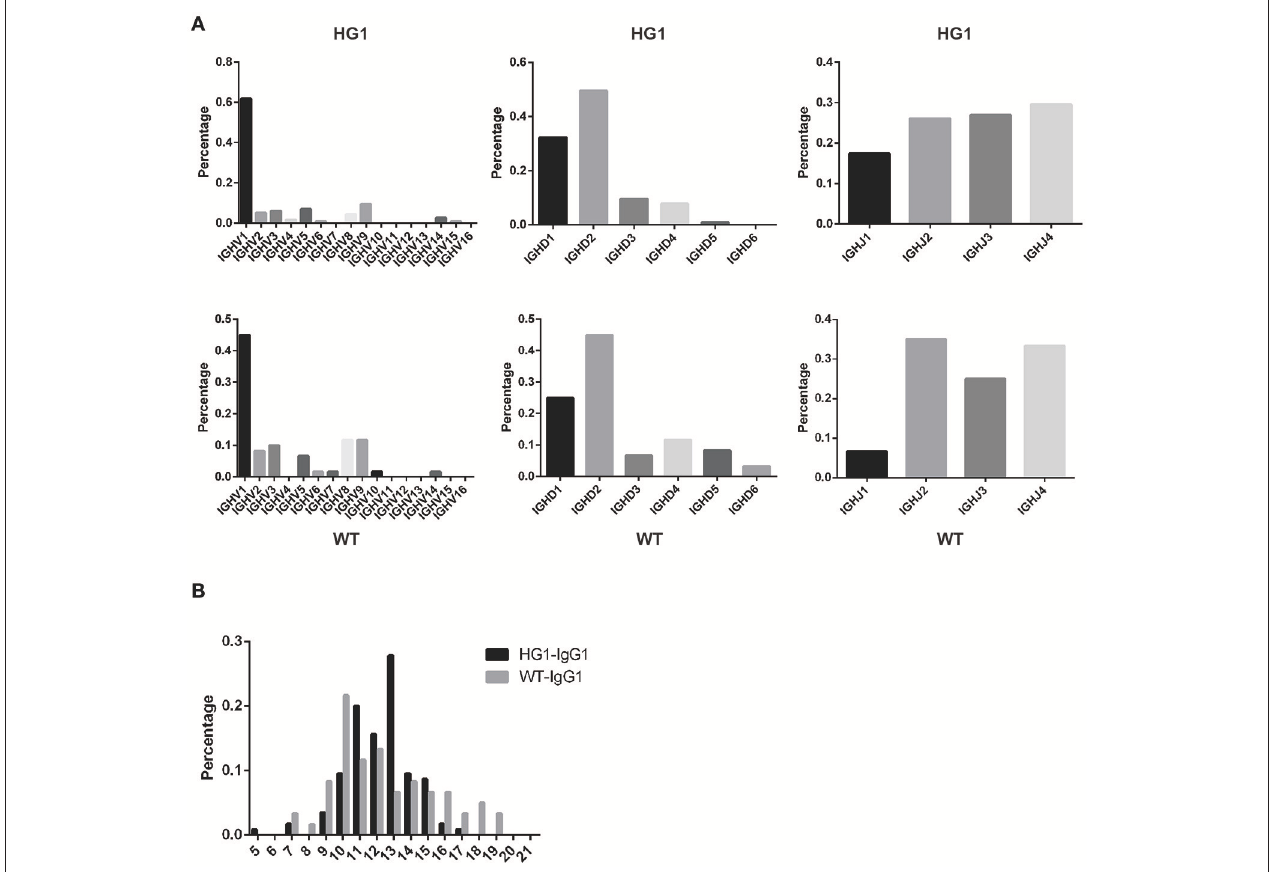
FIGURE 4 | VH gene usage and CDR3 length analyses. (A) The usage of the V, D, and J genes of the γ 1 transcripts in HG1 (upper panel) and WT (lower panel) mice. (B) Analysis of the length of CDR3 in the IgG1 heavy chains in HG1 and WT